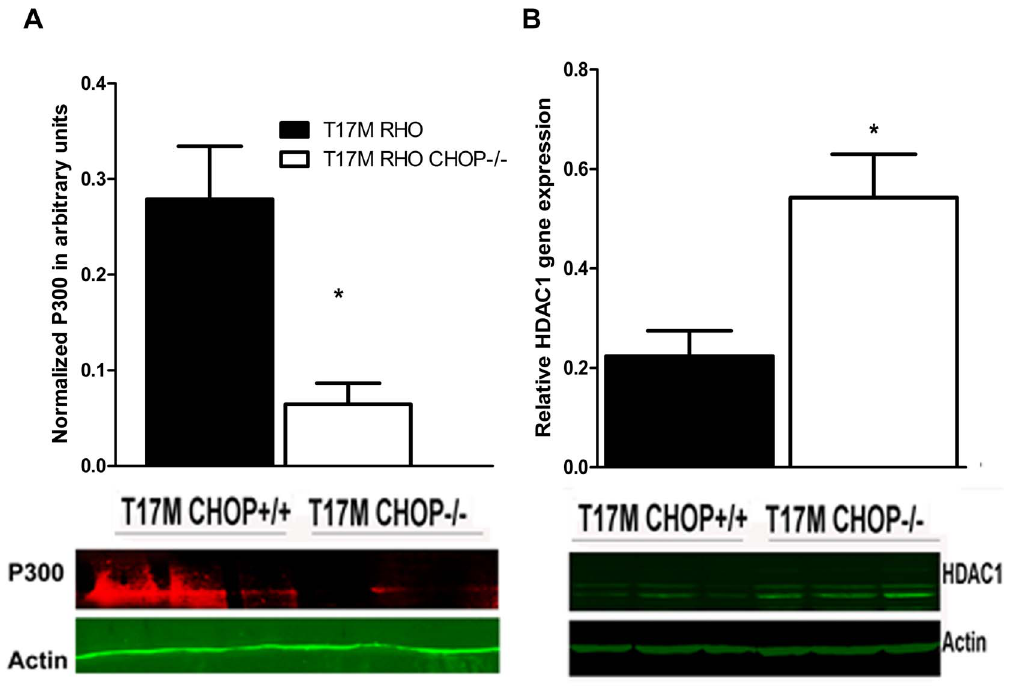
Figure 5. Expressions of the histone deacetylase, Hdac1 and the transcriptional co-activator, P300 were modified in P30 T17M RHO CHOP 2 / 2 retinas (N=3). A: A 78% reduction in the P300 protein level was observed in the T17M RHO CHOP 2 / 2 retina compared to T17M RHO . The normalized level of P300 was 0.3 6 0.06 a.u. in T17M RHO vs. 0.1 6 0.02 a.u. in T17M RHO CHOP 2 / 2 (P=0.02). B: A 245% increase in Hdac1 protein expression was observed in T17M RHO CHOP 2 / 2 retinas (0.22 6 0.05 arbitrary units in T17M RHO vs. 0.54 6 0.08 a. u. in T17M RHO CHOP 2 / 2 , P =0.03). Bottom: Representative images of western blots treated with antibodies against P300, HDAC1 and b -actin proteins.